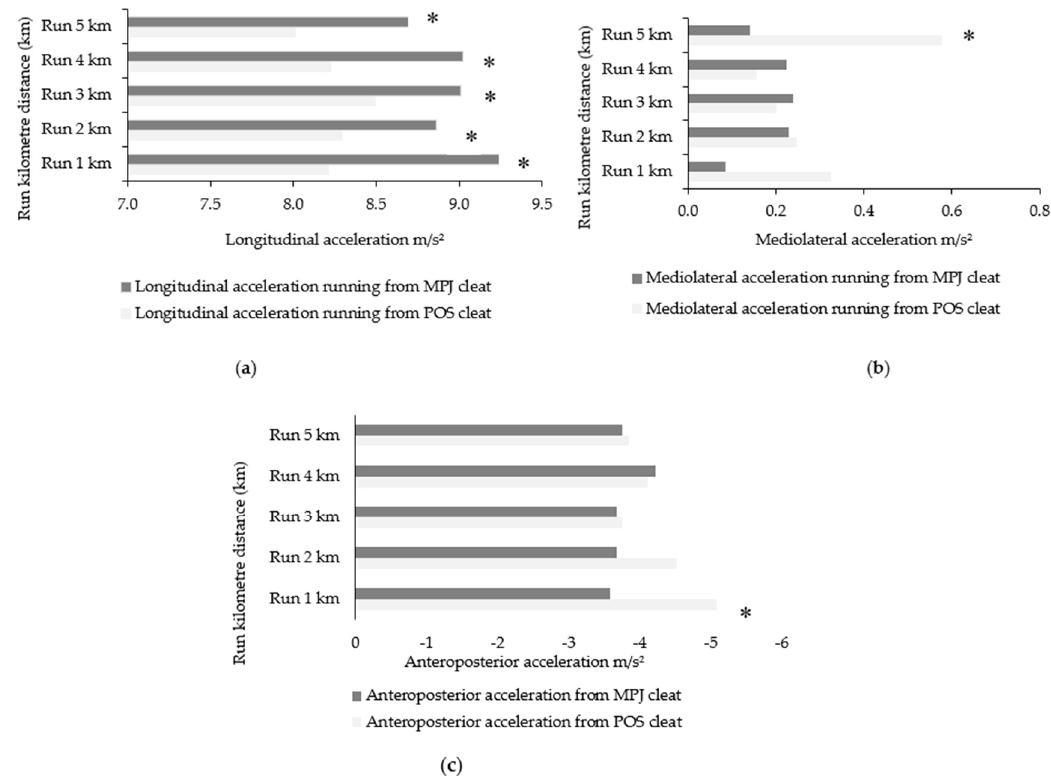
Figure 9. ( a ): Longitudinal acceleration magnitudes per kilometre in running after POS and MPJ cleat positions; ( b ) Mediolateral acceleration magnitudes per kilometre in running after POS and MPJ cleat positions; ( c ) Anteroposterior acceleration magnitudes per kilometre in running after POS and MPJ cleat positions. POS = posterior cleat. MPJ = metatarsophalangeal joint cleat position. * Significant at p < 0.5.